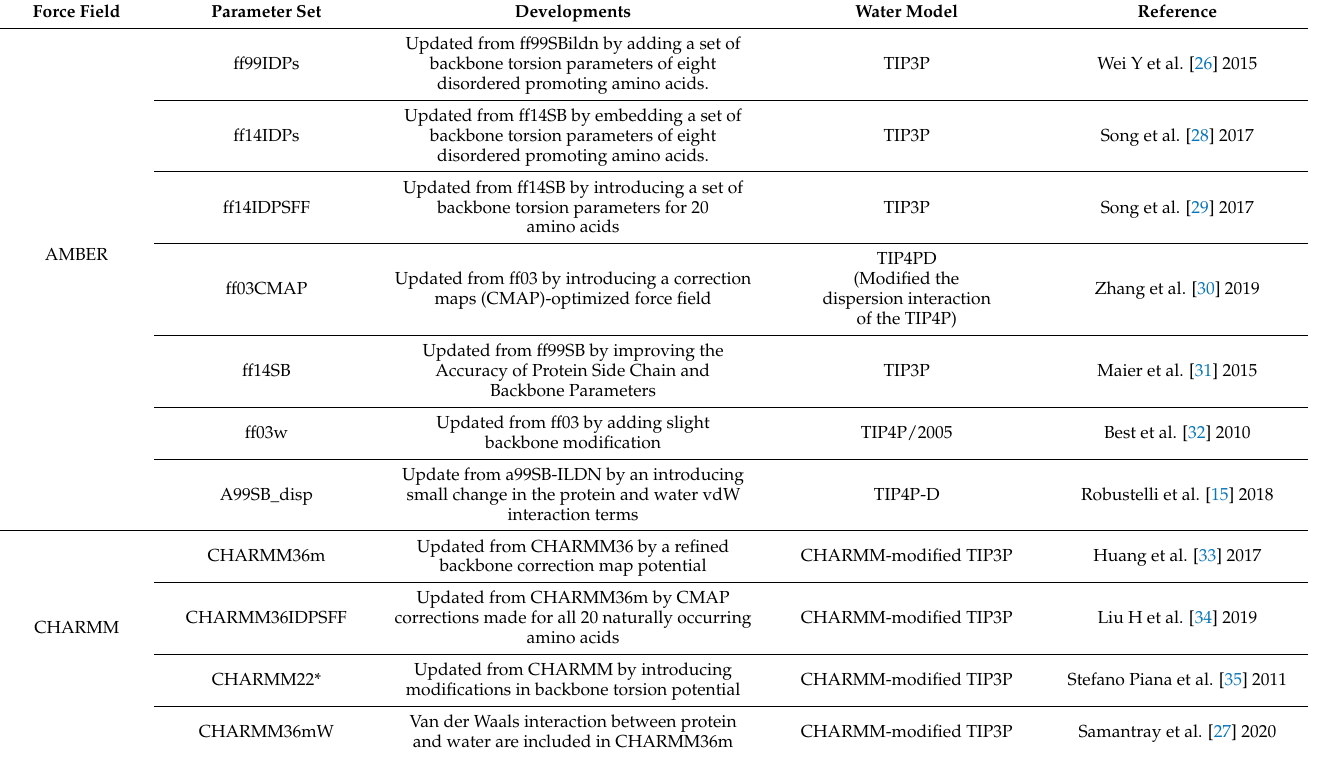
Table 1. Latest developed force field for intrinsically disordered protein and water